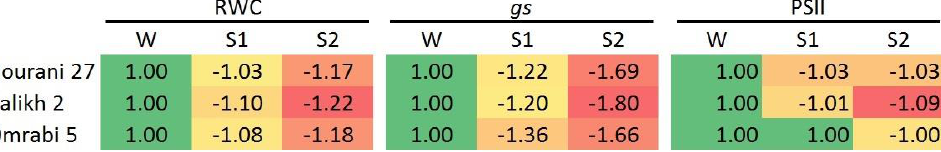
Figure 2. Heat map of relative change in RWC, stomatal conductance ( gs ) and PSII activity in three durum wheat cultivars (Hourani 27, Balikh 2 and Omrabi 5) during S1 and S2 stress stages as compared to the control W.